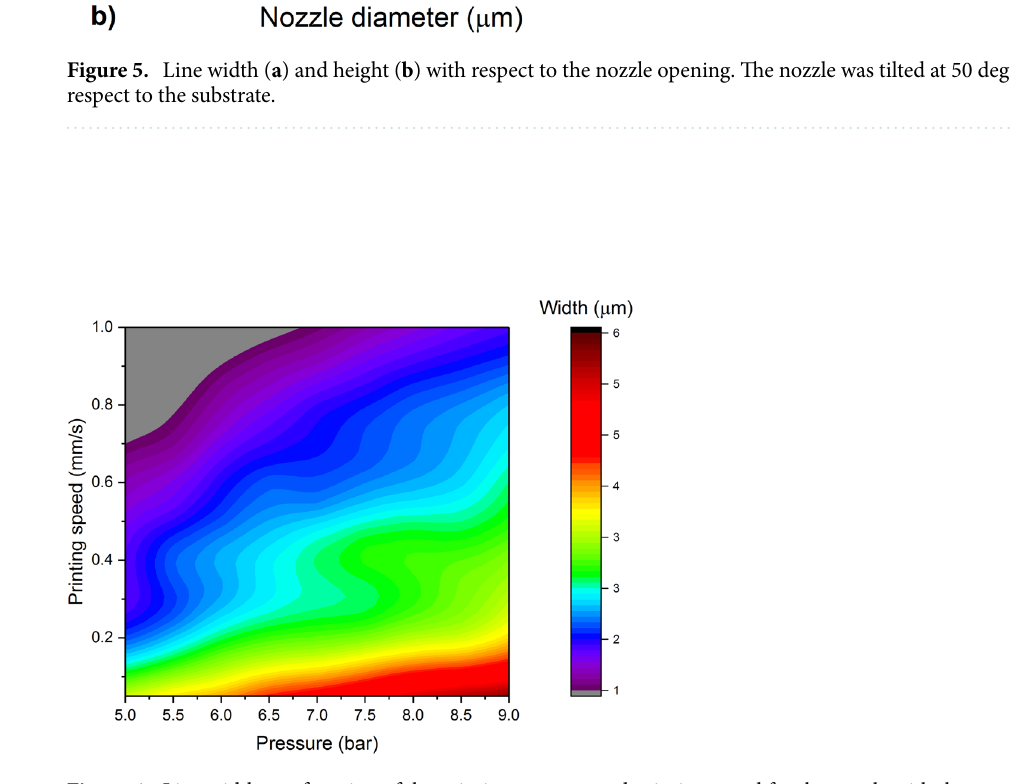
Figure 6. Line width as a function of the printing pressure and printing speed for the nozzle with the opening of 3.5